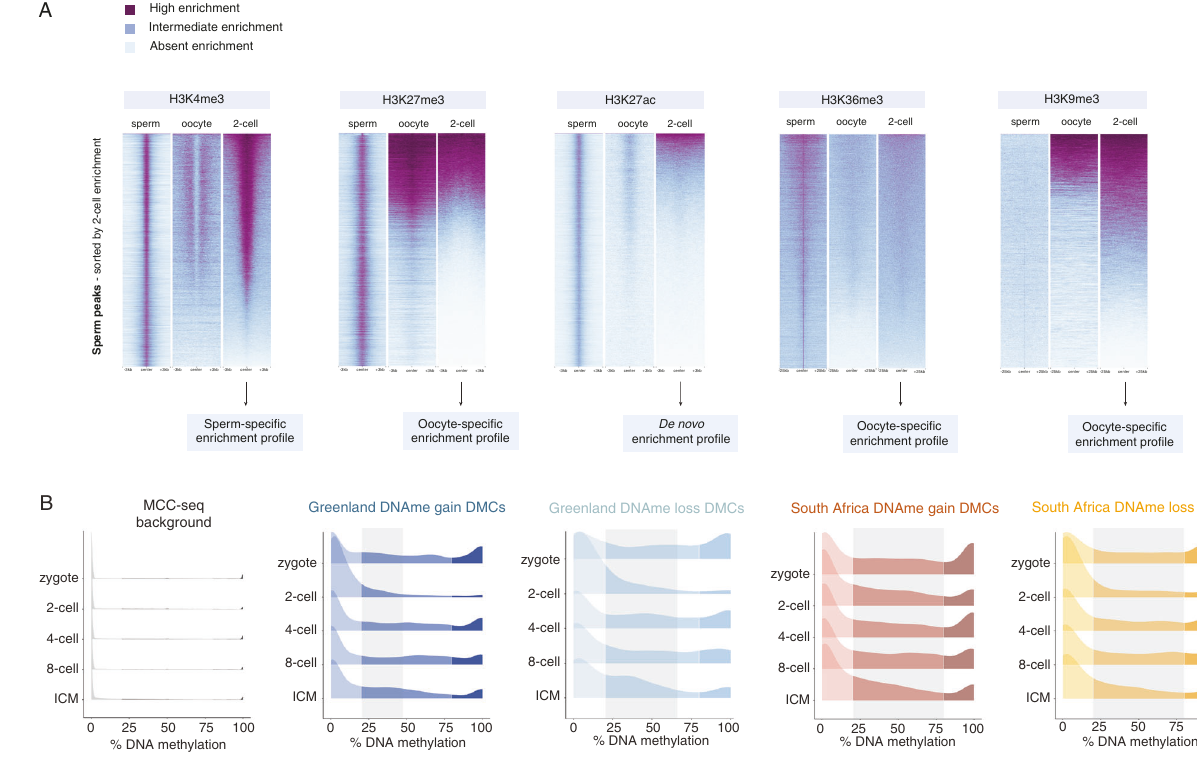
Fig. 2 | Chromatin marks in sperm and their relationship to the oocyte and 2-cell embryo. A Heatmaps indicating H3K4me3, H3K27me3, H3K27ac, H3K36me3, orH3K9me3regionsinspermandthesemarks ’ enrichment in theoocyteandin 2-cell embryos .ColorofthesignalcorrespondstorelativeRPKMcounts.SpermH3K4me3 and H3K27me3 datasets were generated from Lismer et al. 54 ; oocyte H3K4me3 dataset was retrieved from Liu et al. 110 ; 2-cell H3K4me3 dataset was retrieved from Liu et al. 110 . Sperm H3K27ac dataset was generated in house; oocyte and 2-cell H3K27ac datasets were retrieved from Dahl et al. 111 . Sperm, oocyte, and 2-cell H3K36me3datasetswereretrievedfromXuetal.,2018 63 .Sperm,oocyte,and2-cell H3K9me3datasetswereretrievedfromWangetal. 46 .RawFASTQ fi leswerealigned as indicated in Lismer et al. 9 . Regions with histone post-translational histone enrichments in sperm were identi fi ed using the csaw Bioconductor package 170 .